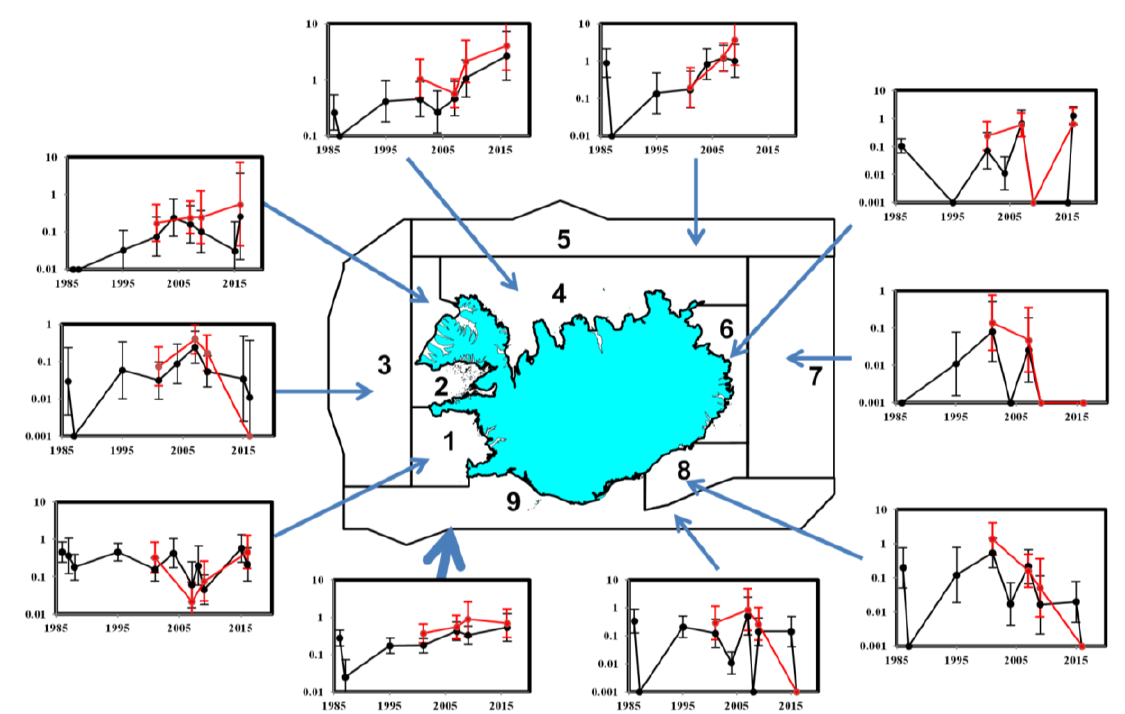
Figure 13. Trends in the relative abundance (black line, uncorrected line transect density, whales nm -2 ) and density corrected for perception bias (red line) of white-beaked dolphins by stratum and for the entire survey area (thick arrow). Zero values of density are shown as the lowest value on the Y-axis. 95% confidence intervals are